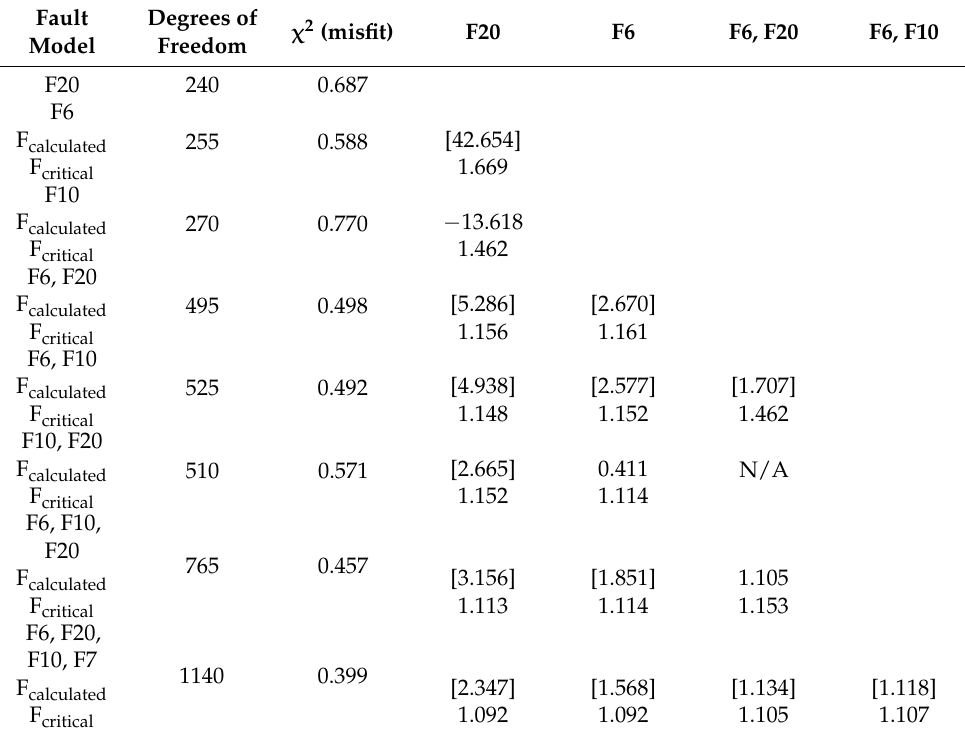
Table 4. Comparison of the goodness-of-fit χ 2 values and the calculated versus critical F-test values for fault models consisting of different numbers of fault segments. The calculated and critical F-test values were utilized to check if a model in a given row provides a better fit to the InSAR observation with 95% confidence than another model in a given column. F calculated > F critical indicates that the model in this row has a better fit than the model in this column, and the F calculated is displayed in square brackets in such